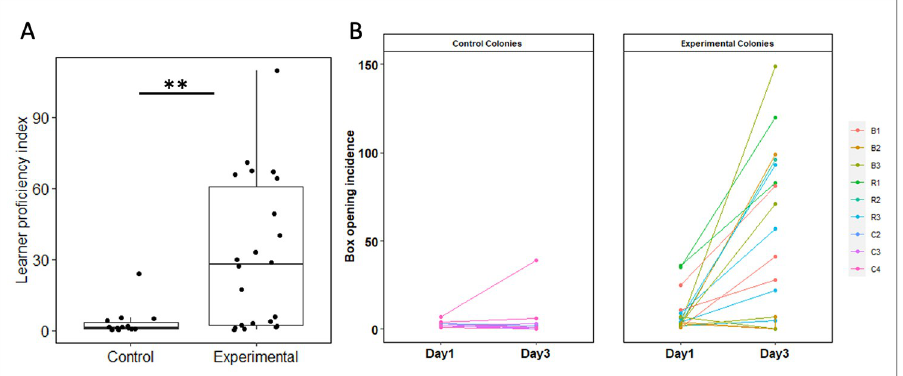
Fig 2. Learner proficiency is higher in bees exposed to a demonstrator compared with those without and increases more rapidly. (A) Difference in proficiency between learners from experimental and control colonies. Proficiency indexes were calculated for each individual learner as follows: total incidence of box opening/days spent as a learner, with the latter spanning from the day learning criteria was met to the end of the diffusion. Control, n = 14, including data from colonies C2–4; experimental, n = 22, including data from colonies R1–3 and B1–3.) �� p < 0.01 (Mann- Whitney U test). (B) Change in learner proficiency from the day learning criteria were met (“day 1”) to 2 days later (“day 3”) in control and experimental diffusion experiments. Learners who did not meet the learning criteria early enough to have data for a third day (e.g., those who met criteria on day 5 or 6 of the 6-day colonies or on day 11 or 12 of the 12-day colonies) were excluded from analysis. Control group, n = 11; experimental group, n = 18. The data underlying this figure can be found in